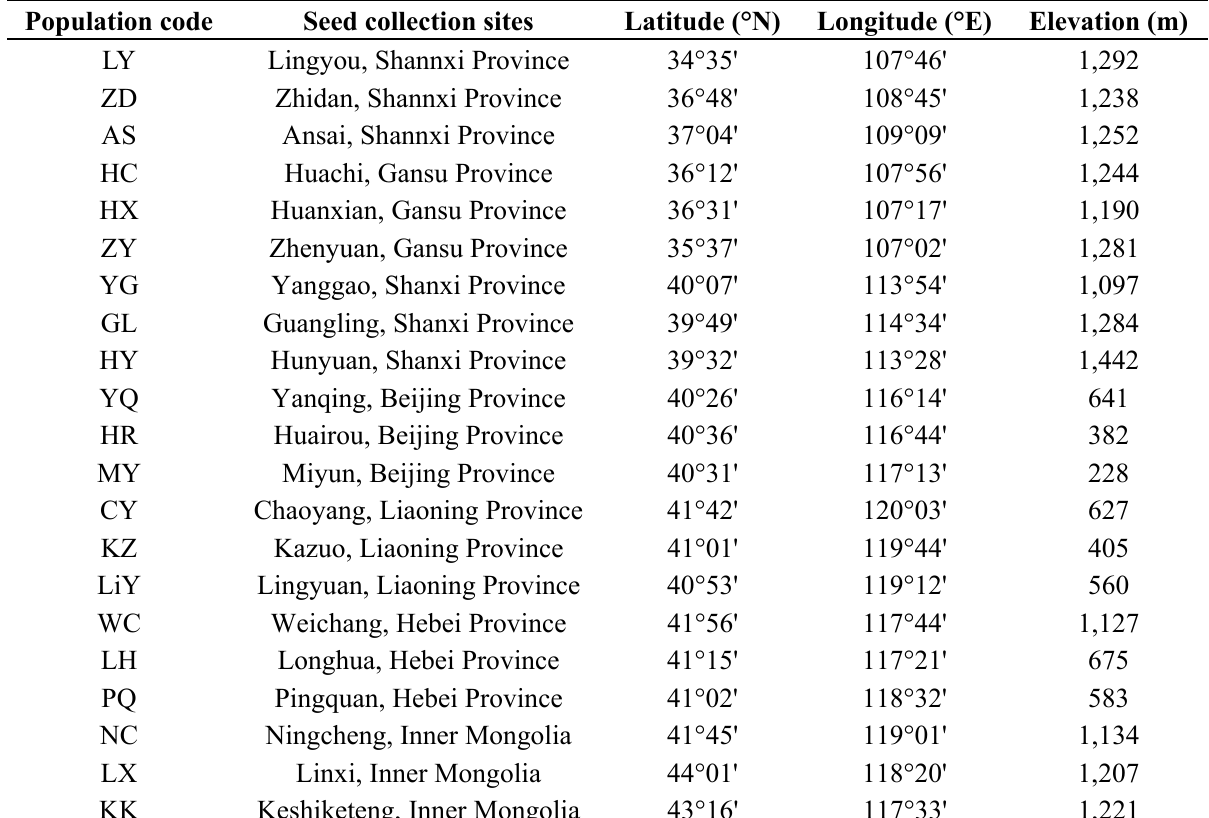
Table 3. Geographical locations of the different P. sibirica populations used in this study. Population